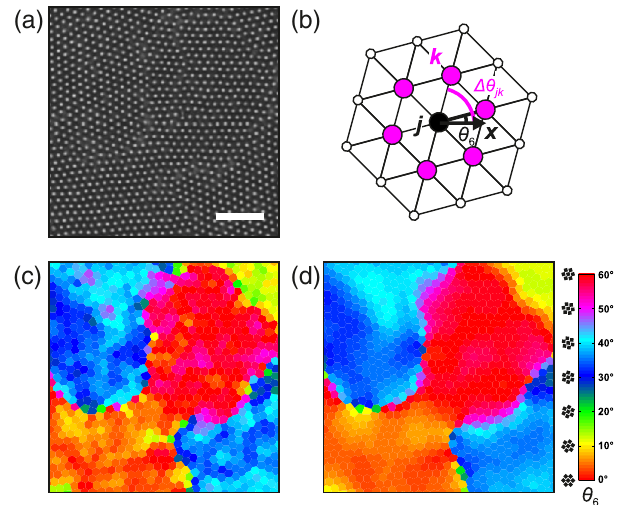
FIG. 6. (a) Microscopy image of a small area of the colloidal polycrystalline monolayer. The scale bar represents 20 μ m. (b) A particle j (black disk) with k , one of its six nearest neighbors in the hexagonal lattice (purple disks). The angle between the bond j − k and the x direction is denoted Δ θ , and it is used for the jk computation of ψ 6 and the local orientation θ 6 (see text). The smoothing of the ψ 6 field requires the particles in the second shell of nearest neighbors (white disks). (c) Voronoi tessellation, where each cell is colored according to the value of θ 6 as indicated by ~ θ the color bar. (d) Smoothed orientation field 6